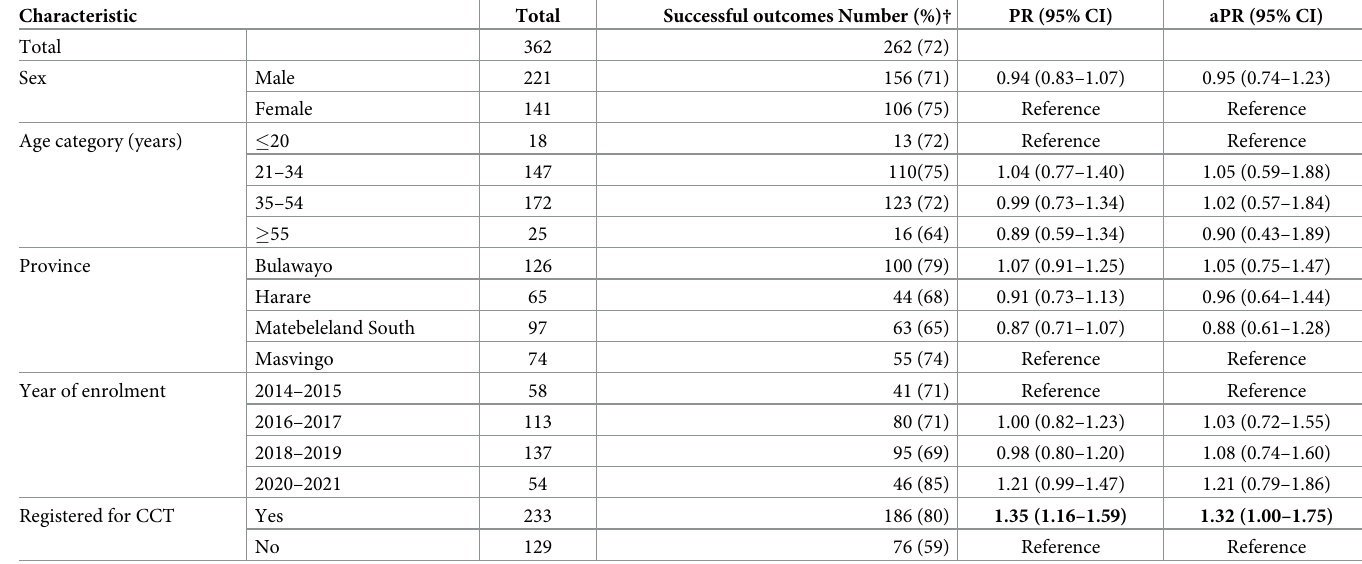
† = Row percentage; PR = prevalence ratio; aPR = adjusted prevalence ratio; CCT = Conditional cash transfer; CI = confidence interval.